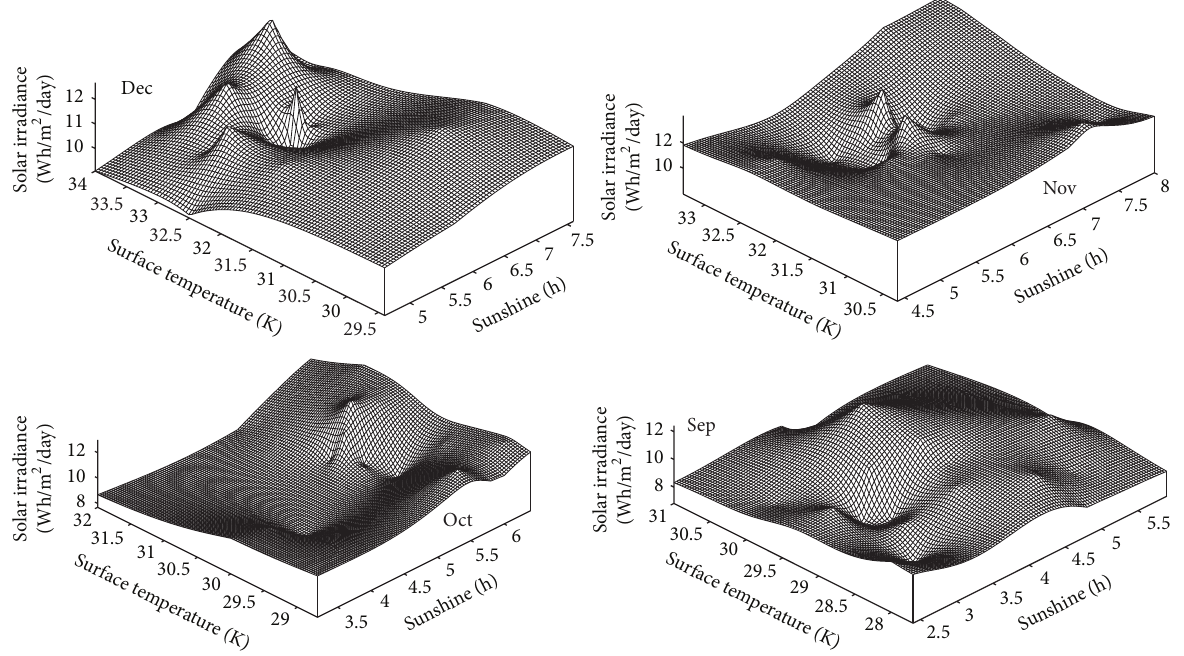
Figure 7: Weather parameter trend for September–December.